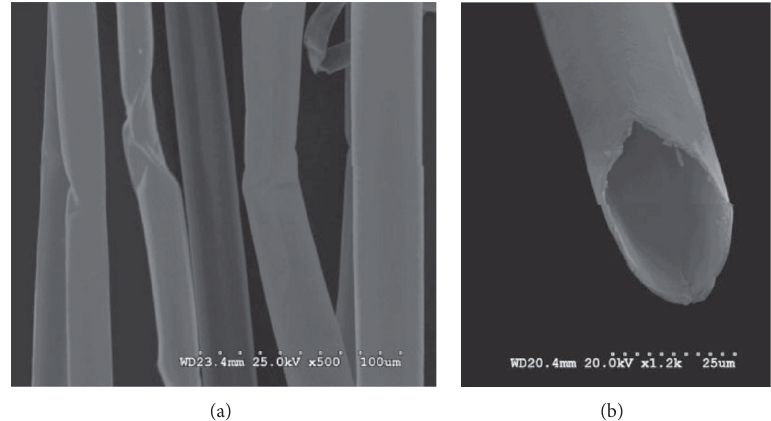
Figure 1: (a) SEM image showing the longitudinal features of the Estabragh fibers. (b) SEM image depicting the unique hollow center and thin cell wall of the Estabragh fiber [26].